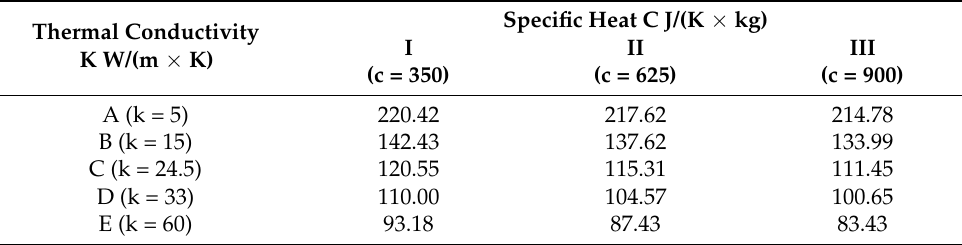
Table 4. Input data for analysis of impact of thermal conductivity and specific heat on the maximum contact wire